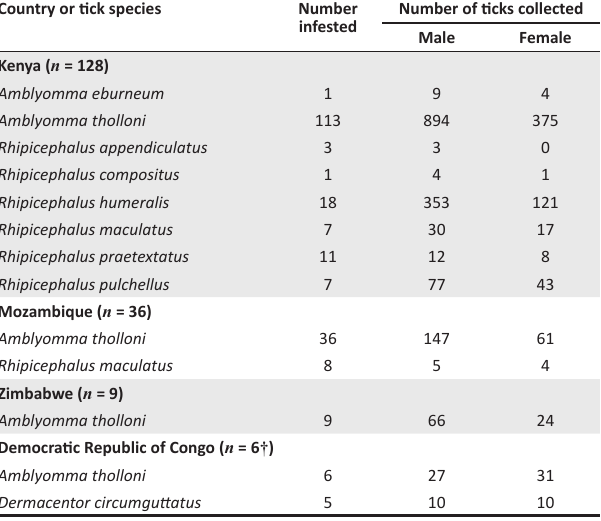
TABLE 1: Species and number of ticks collected from savanna and forest